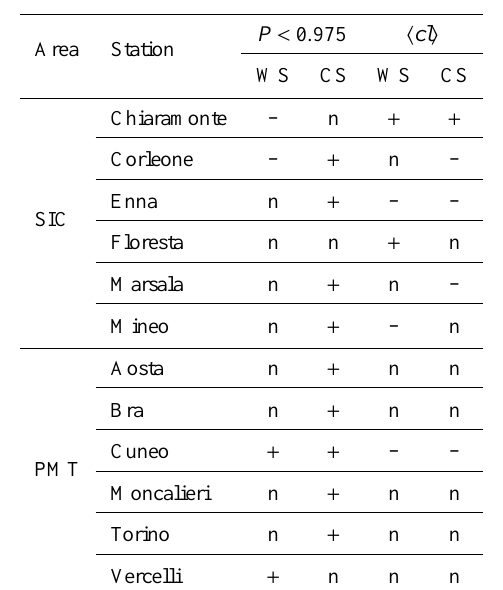
Table 2. Summary of the qualitative trend analysis carried out for a T-quantile ( P < 0 . 975) and for the average cluster size. The symbol ( + ) indicates positive trend, (–) indicates negative trend and (n) no-